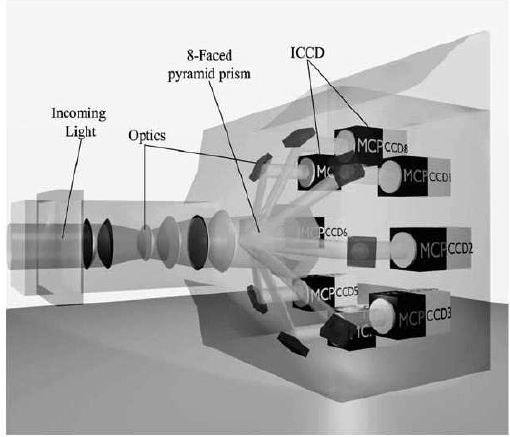
Figure 48. Architecture of the framing camera, showing the eight faced prism splitting the light equally to eight ICCD cameras